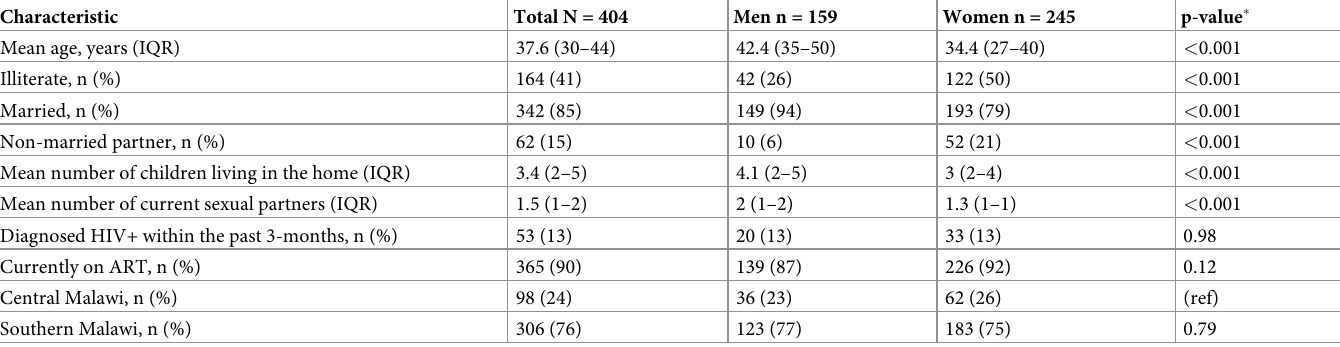
Table 1. Baseline characteristics of HIV-positive clients with an active sexual partner (n = 404).